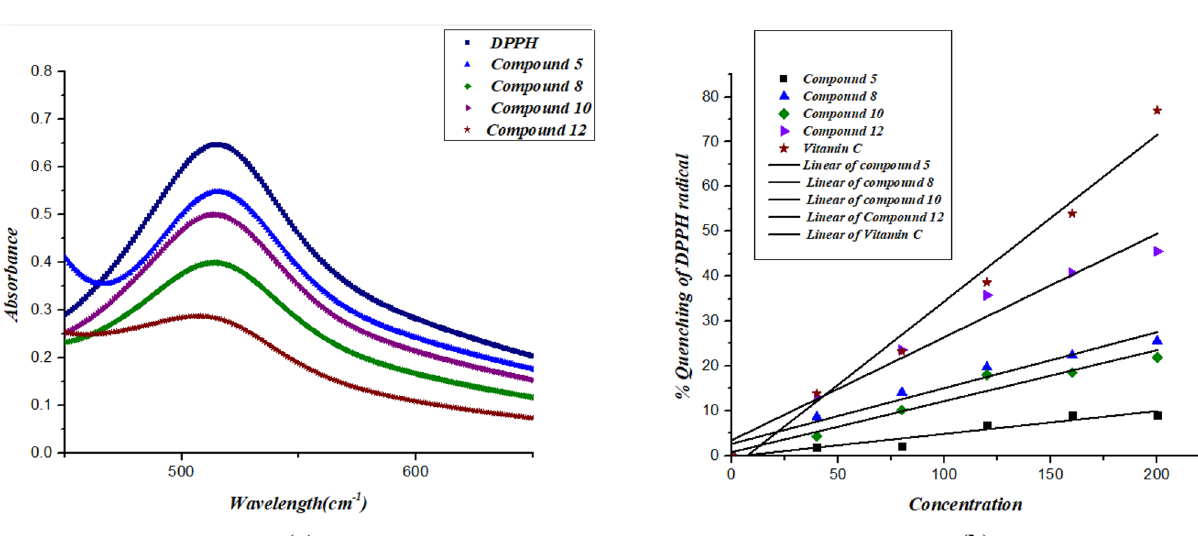
Figure 7. (a) Typical absorption spectra of 100 µM of the DPPH radical alone and in presence of a 200 µM concentration of compounds 5–12 and vitamin C. (b) A diagram of the percentage of quenching of the DPPH radical against the concentration of the antioxidants 5–12 and vitamin